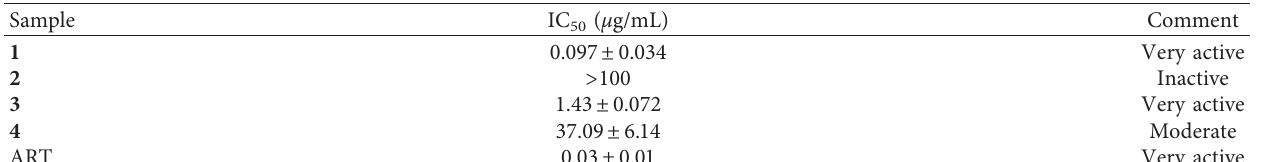
Table 3: IC 50 values for fractions.